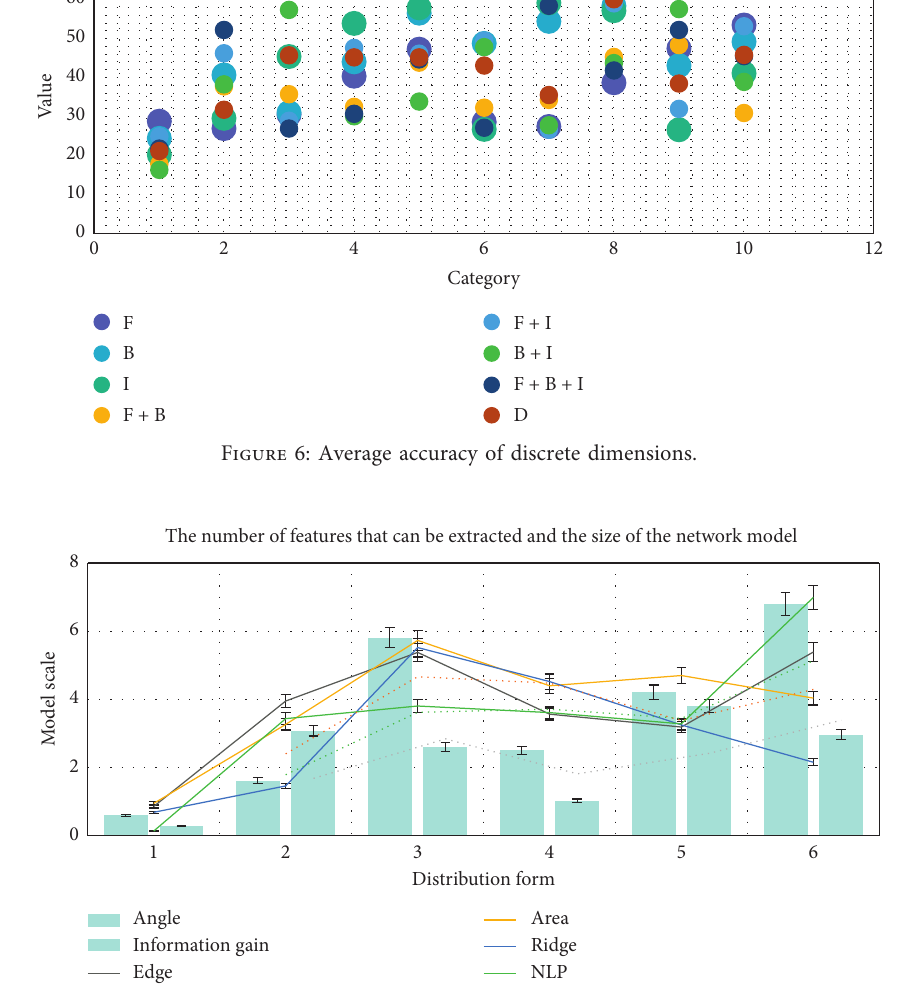
Figure 7: The number of features that can be extracted and the size of the network model. Table 7: Comparison of the effects of gray matter intensity and white matter on the